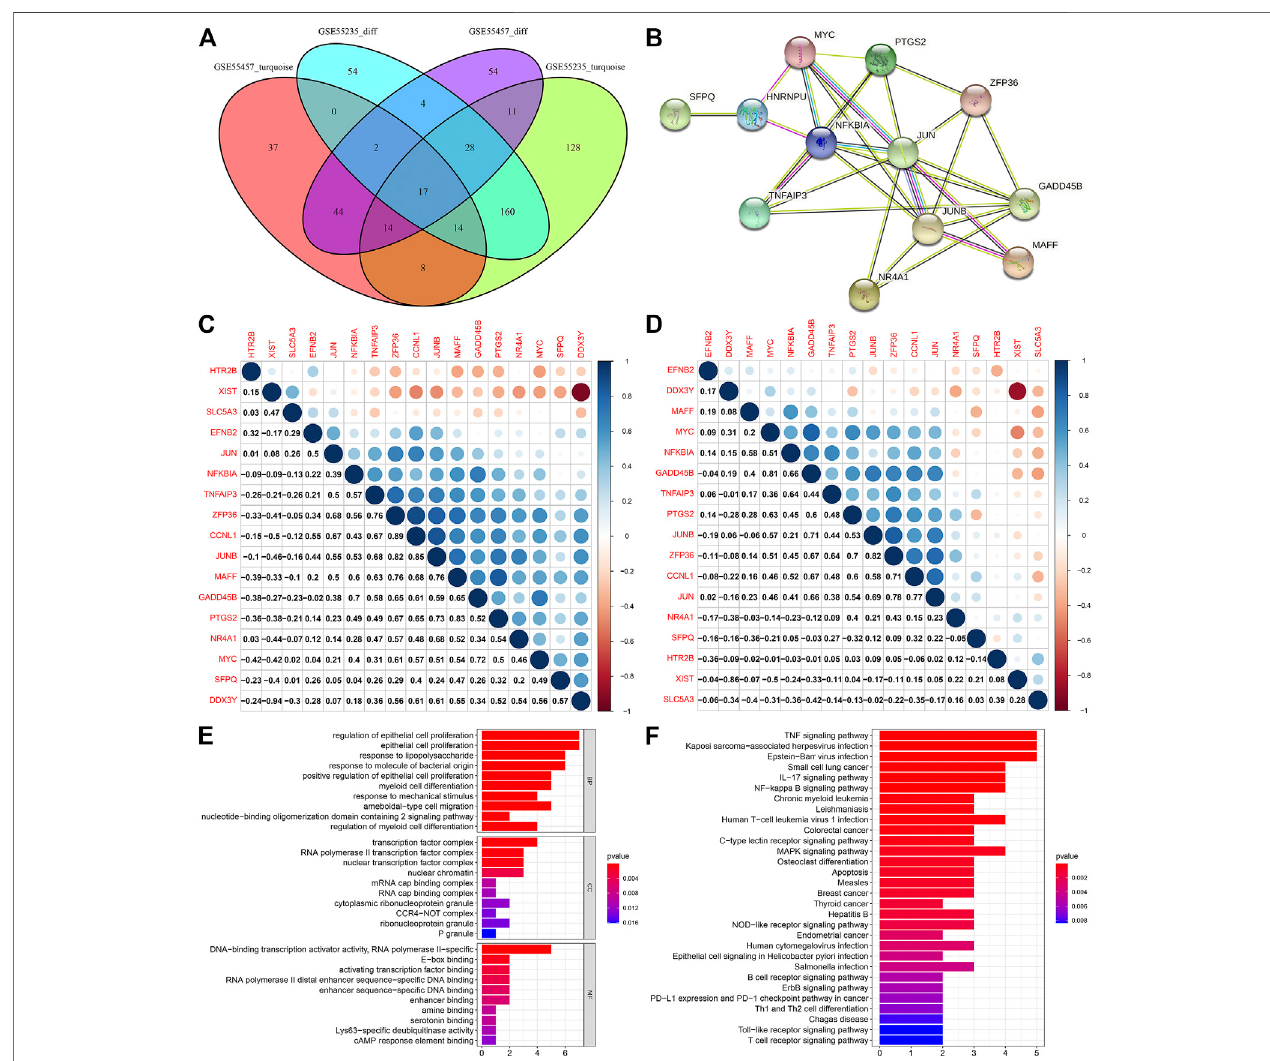
FIGURE4| IdentifyingOA-speci fi cDEGsandtheirfunctions. (A) VenndiagramforOA-speci fi cDEGsbyintersectionsofgenesintheturquoizemodulesandDEGs. (B) A PPI network based on OA-speci fi c DEGs. (C,D) Heatmap for the correlations between OA-speci fi c DEGs in the (C) normal and (D) OA samples. Blue represents positive correlation and red represents negative correlation. The bigger the circle, the stronger the correlation. (E,F) GO and KEGG enrichment analysis results of OA- speci fi cDEGs. The ordinate representsthe GO entry or the KEGG pathway, and the abscissa represents the percentage ofthe enriched genes in the module. The length of the rectangle represents the number of enriched genes, and the color of the rectangle represents the p value.